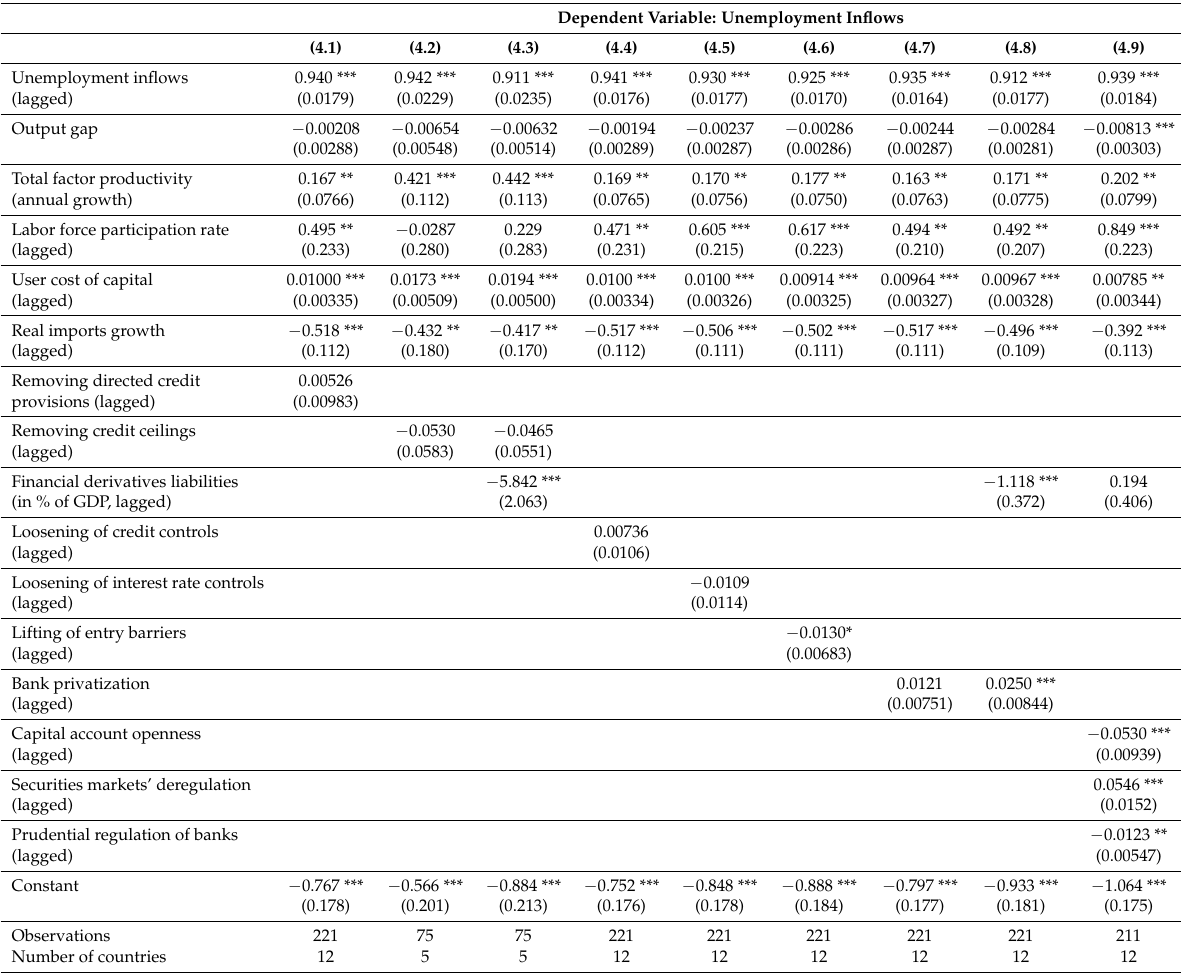
Table 4. Financial sector reforms and unemployment